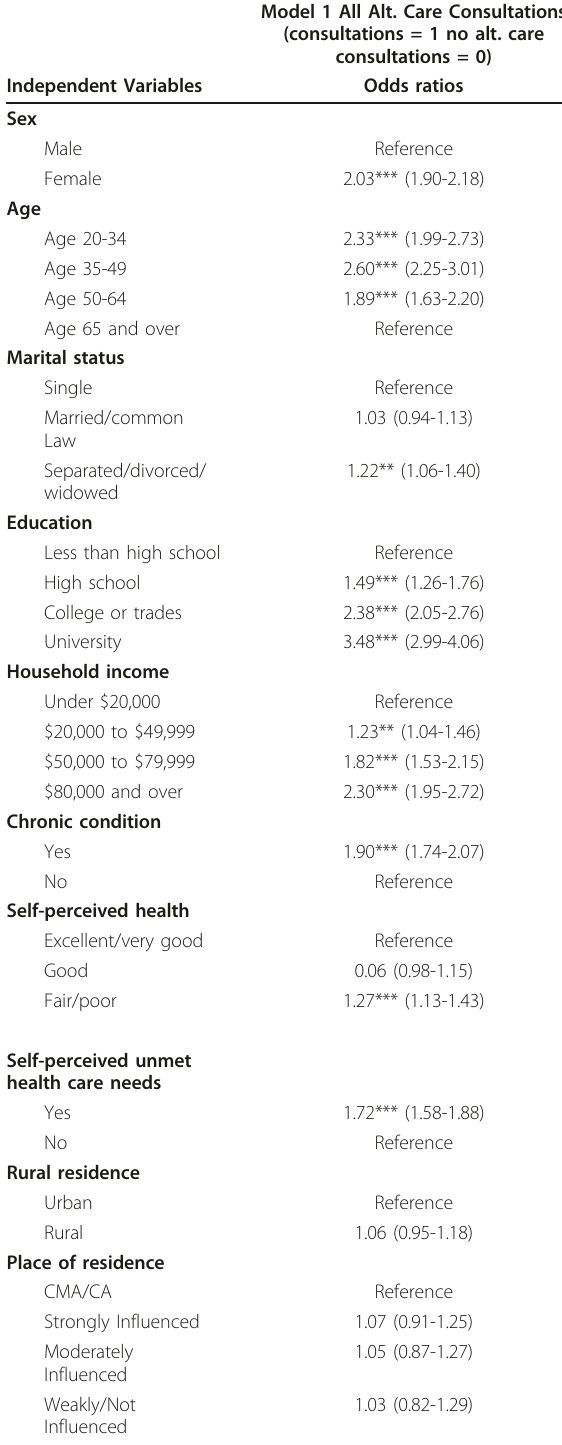
Table 6 Results of Logistic Regression Analyses Alternative Health Care Consultations: All Consultations Age 18 or over, Ontario, 2005 a